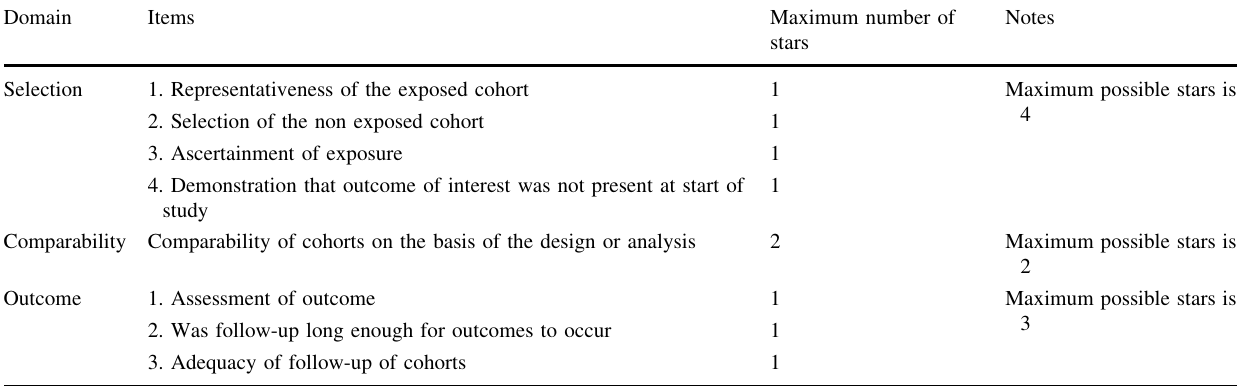
Table 2 Risk of bias assessment tool for cohort studies